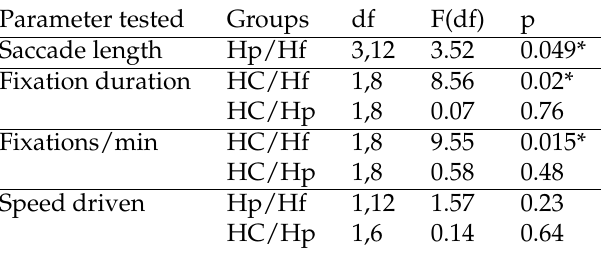
Figure 4 . Head movements to the left/right. For each of the subject subgroups, the mean and standard deviation of the magnitude of head orientation change per second is shown. The individual measurements contributing to the mean are shown as crosses. Subjects are divided into the following sub- groups: HC: control group, HR: HVFD patients with a right- sided visual field defect, HL: HVFD patients with a left-sided defect.